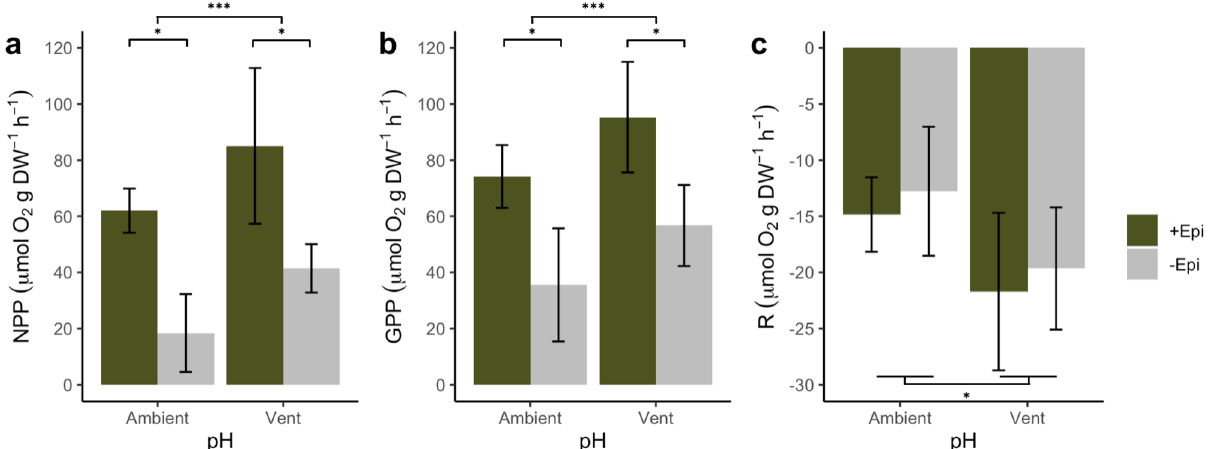
Figure 2. Ex situ net primary production ( a ), gross primary production ( b ), and respiration ( c ) of leaves with epiphytes (+ Epi, green) and without epiphytes (− Epi, grey), from vent and ambient pH sites, normalized by seagrass leaf biomass (dry weight). Negative values represent oxygen consumption, while positive values show oxygen production. Error bars indicate 95% confidence intervals. Stars show significant differences; number of